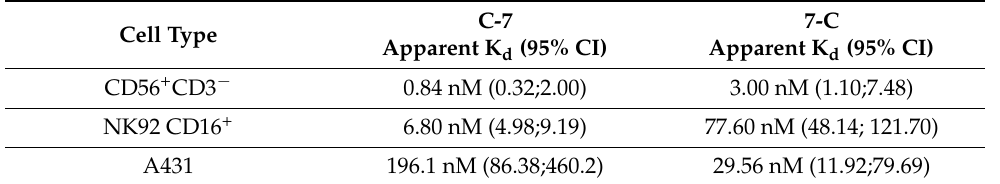
Table 1. Apparent K d of C-7 and 7-C towards CD16 and